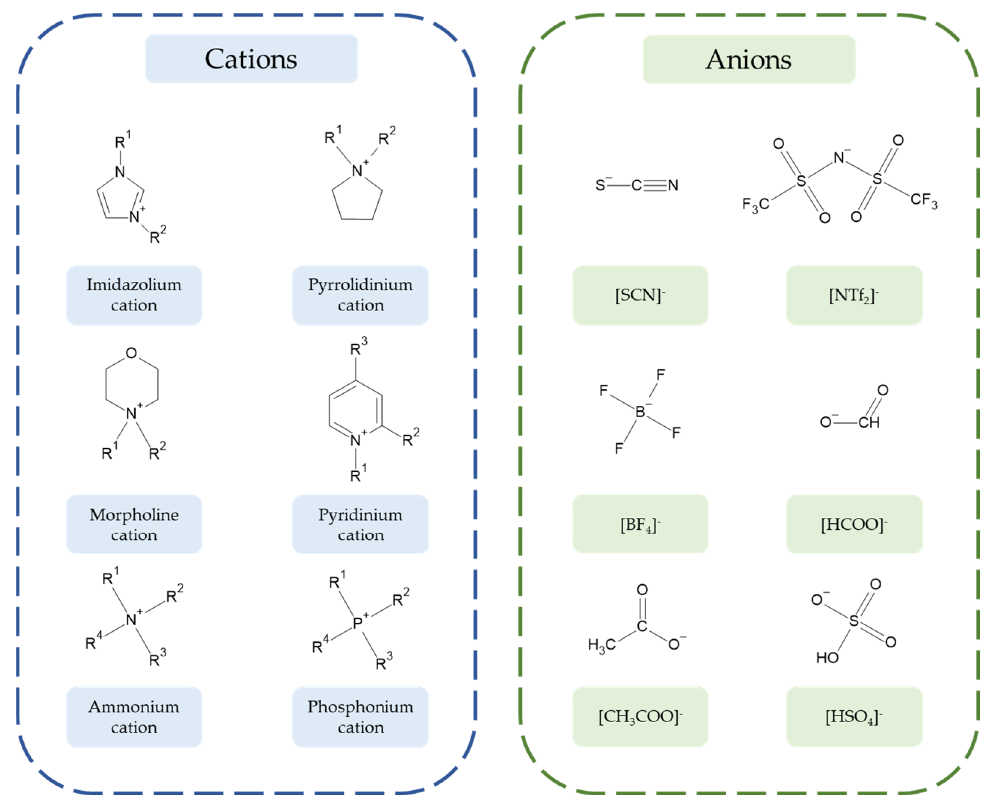
Figure 9. Ionic liquids cations and anions, which are the most frequently applied in biomass transformations (R—hydrogen atom or alkyl group). Table 2. Biomass solubility in ionic